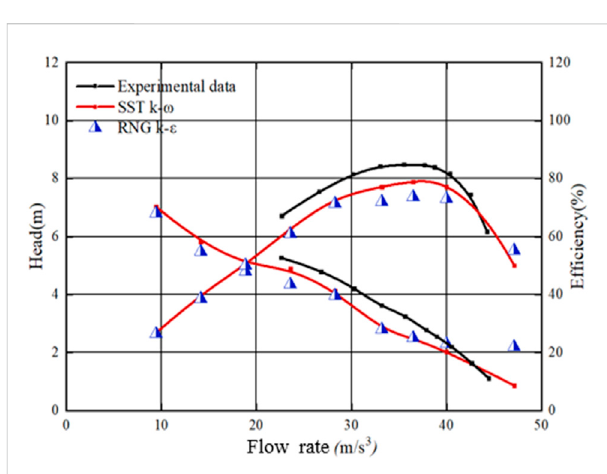
Comparisonofnumericalandexperimentalresultsfromdifferent turbulence